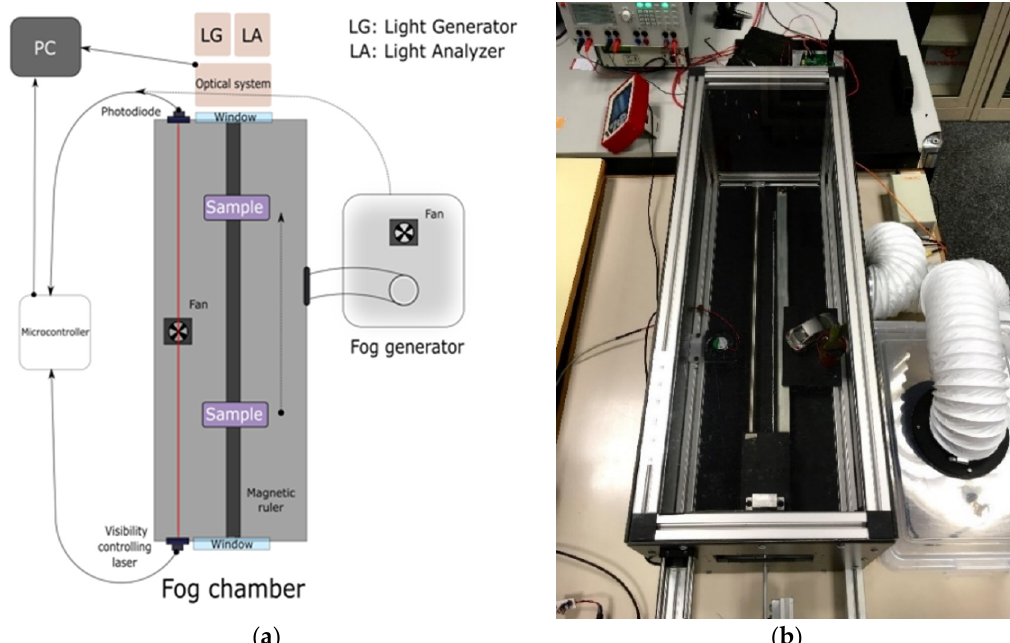
Figure 1. Small-scale fog chamber. Experimental setup used to perform the experiments: ( a ) Schematics; ( b ) Image of the fog chamber.